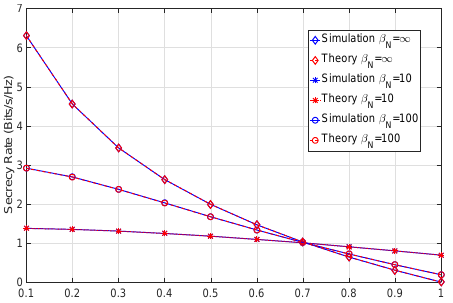
Figure 6. Secrecy rate of the system for an SNR of 12 dB and various levels of channel estimation error on both sides.